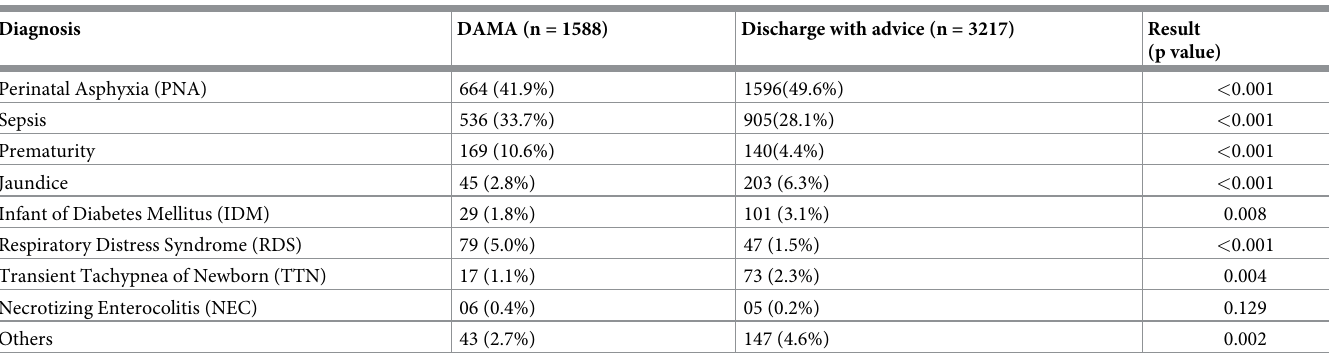
Table 2. Disease profile of DAMA.